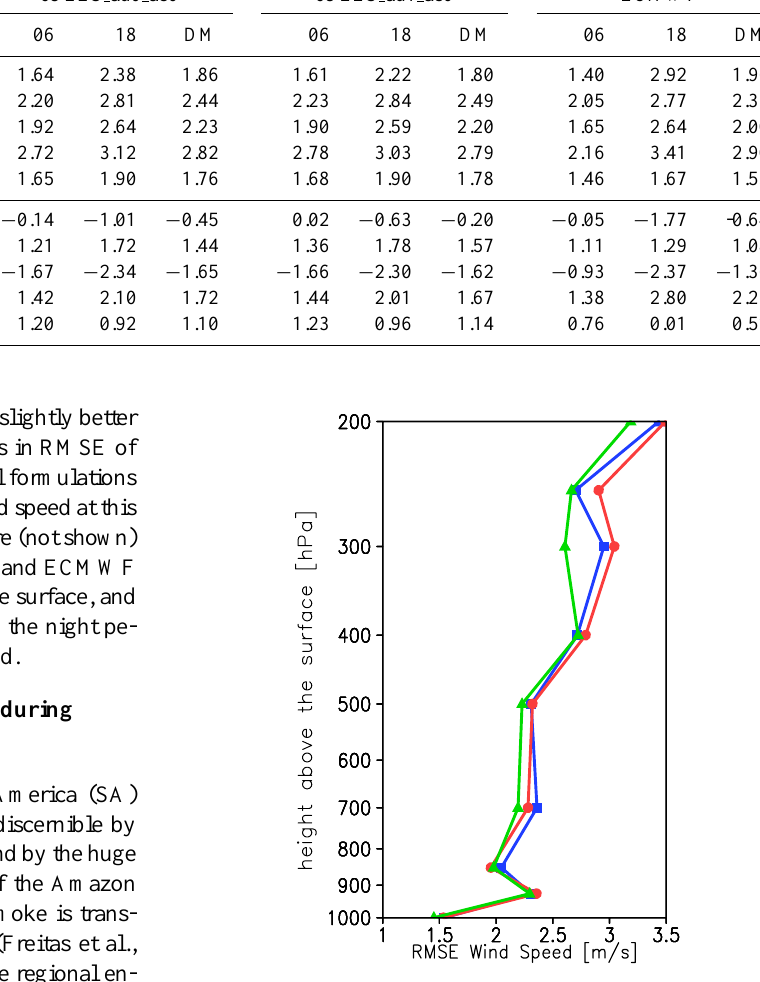
fect of smoke aerosols (radiation absorption and scatter- ing)